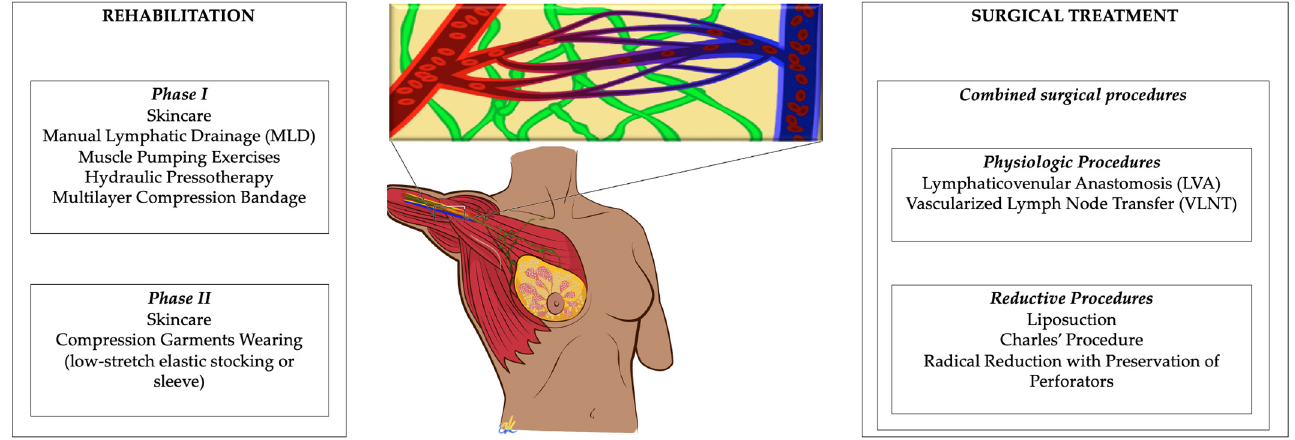
Figure 1. Management of lymphedema from a Plastic Reconstructive Surgeons and Physical and Rehabilitative Medicine point of view.